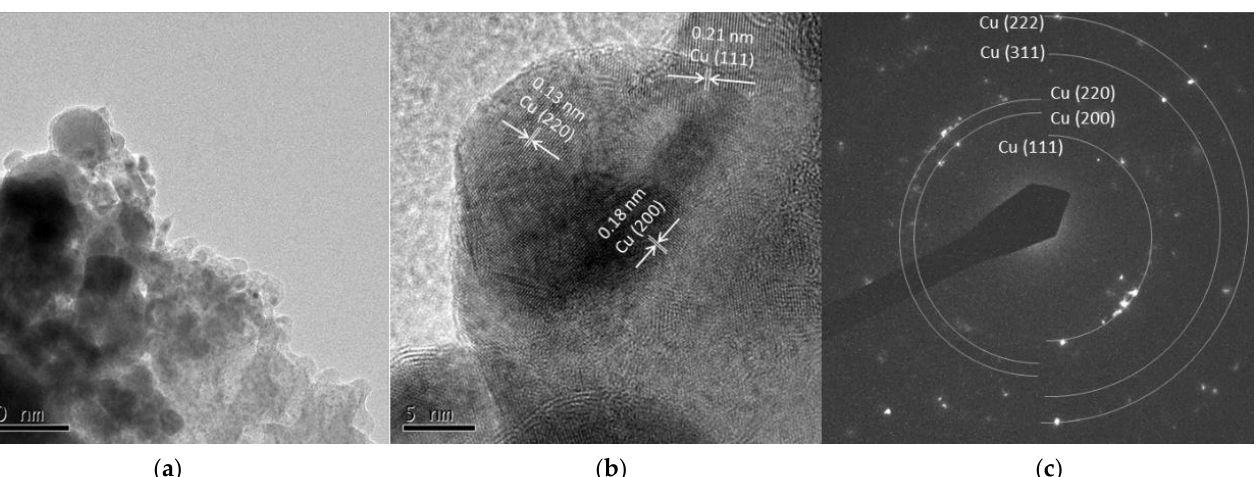
Figure 8. TEM images of Al 30 A particles ( a ) low resolution image; ( b ) high resolution image; ( c ) SAED pattern.